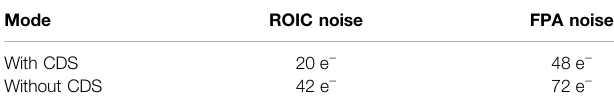
TABLE 3 | Noise measurement results of FPA and